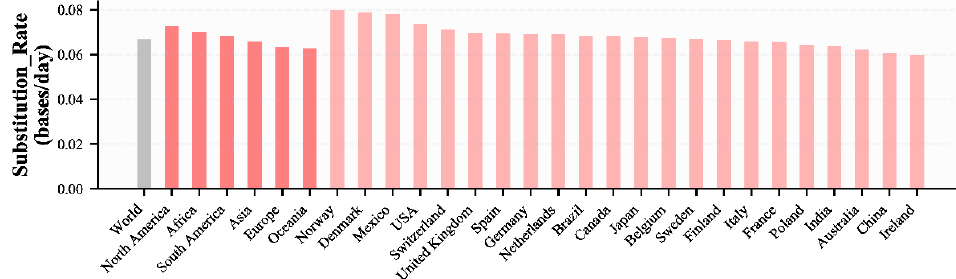
Figure 1. The estimated substitution rate of SARS-CoV-2. The estimated substitution rate of different continents, countries with genome sequences >10,000, and China were plotted, while that of Turkey was not plotted because it had a small Pearson correlation coefficient (r = 0.20).